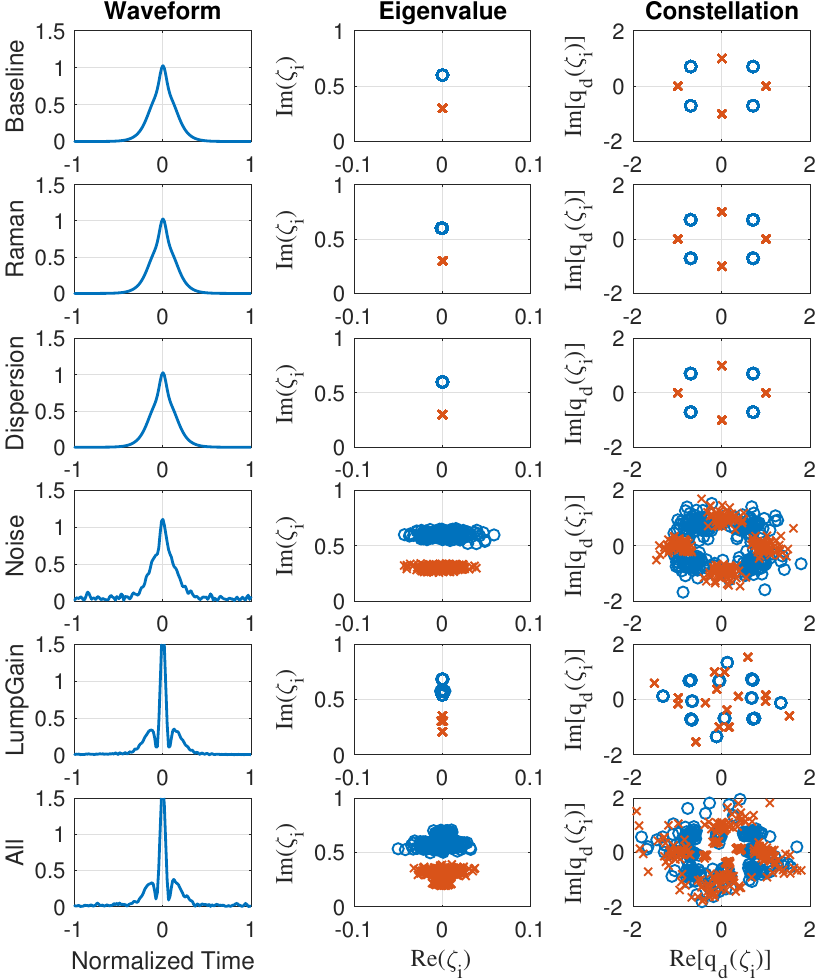
Figure 17. Simulation results with 1600 km of propagation distance and 0 dBm of launch power for second-order solitons. These results were obtained with a symbol period equal to T S2 . The first column shows a waveform of a sampled symbol of the transmitted sequence for each effect respectively. The second column shows the received eigenvalues. The third column shows the normalized received spectral function constellations, q d ( ζ 1 ) (blue circles) and q d ( ζ 2 ) (red crosses).